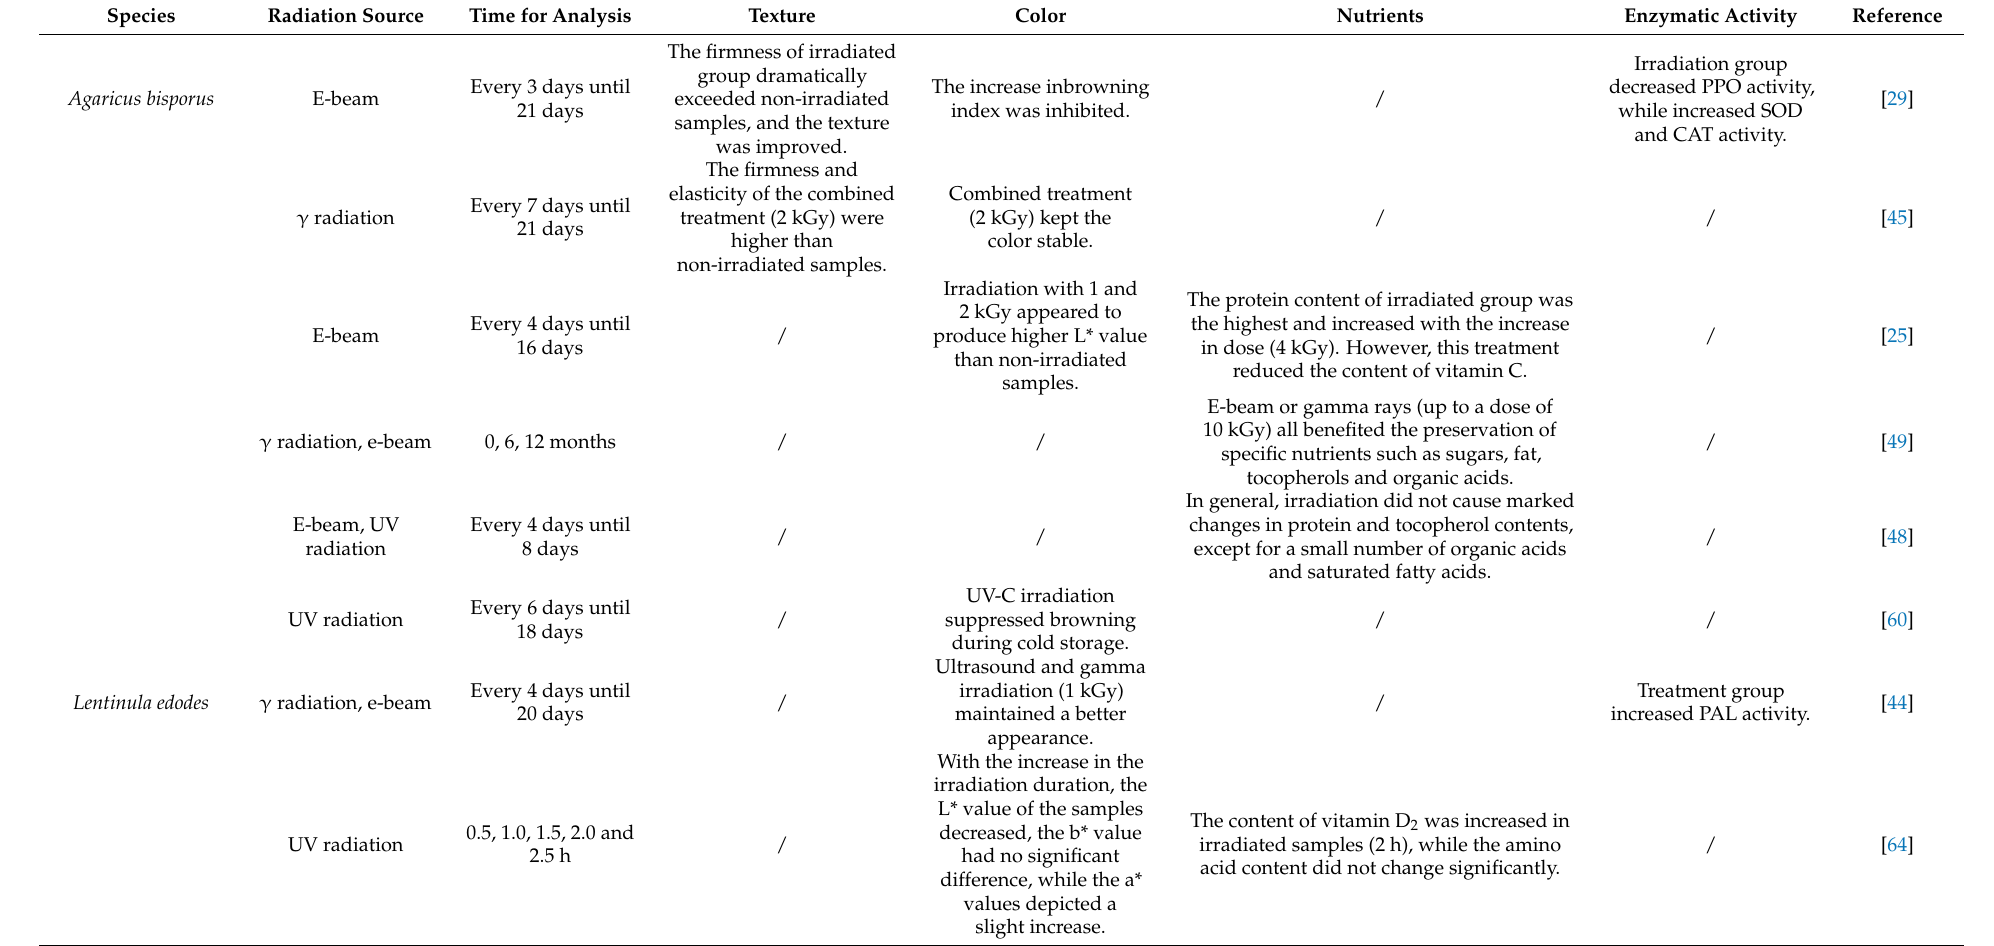
Table 3. Effects of irradiation on physico-chemical, biochemical parameters and nutritional properties of edible fungi.